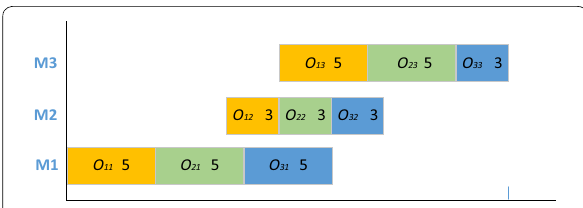
Figure 1 Gantt chart of NIFSP